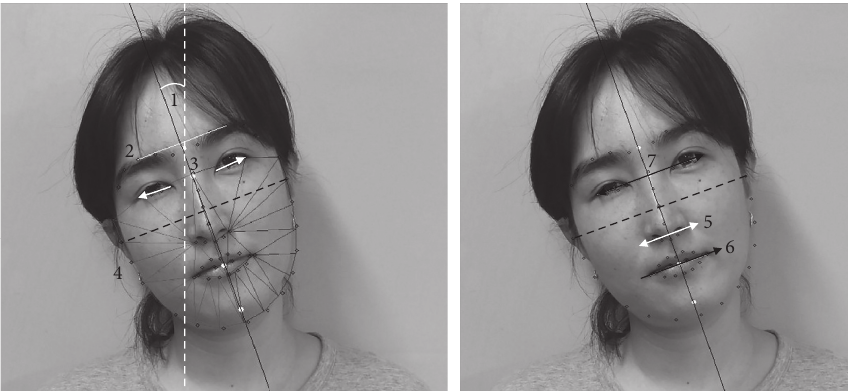
Figure 2: Seven indices of facial asymmetry automatically measured by the software. (1) Face tilt ( ° ) is the angle between the vertical line (white dotted line) and the line that passes between the landmark points of the facial midline (black line). (2) Slope of eyebrows ( ° ) is the angle between the line connecting both eyebrows (white line) and the perpendicular line to the facial midline (black dotted line). (3) Difference in slopes of eyes ( ° ) is calculated by the difference in slopes of the lines passing through the eye corner points of each eye (white arrows). (4) Difference in hemifacial area (%) was calculated by the proportion of “absolute difference of left and right hemifacial area” to “total face area.” (5) Nose deviation ( ° ) is the angle between the line connecting the corners of the nasal base (white double headed arrow) and the perpendicular line to the facial midline (black dotted line). (6) Slope of lips ( ° ) is the angle between the line that passes through the corners of both lips (black arrow) and the perpendicular line to the facial midline (black dotted line). (7) Difference in slopes of eye and mouth ( ° ) was calculated by the angle between the line connecting the center of each eye (black double-headed arrow) and the line that passes through the corners of both lips (black arrow). The center of each eye was calculated as the average coordinate of six landmark points on the upper and lower